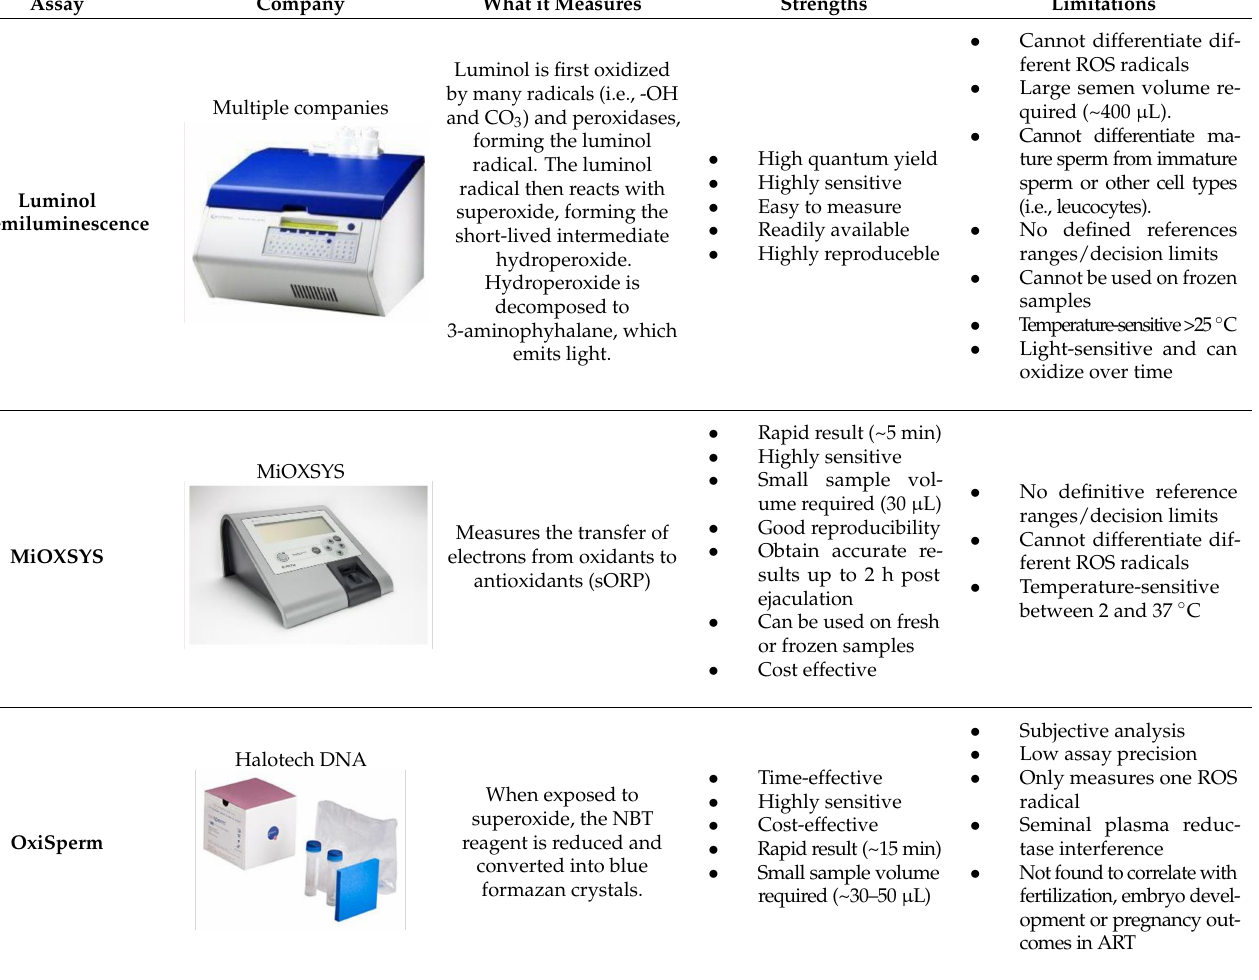
Table 1. Strengths and limitations of current commercially available ROS detection tools for male infertility. Assay Company What it Measures Strengths